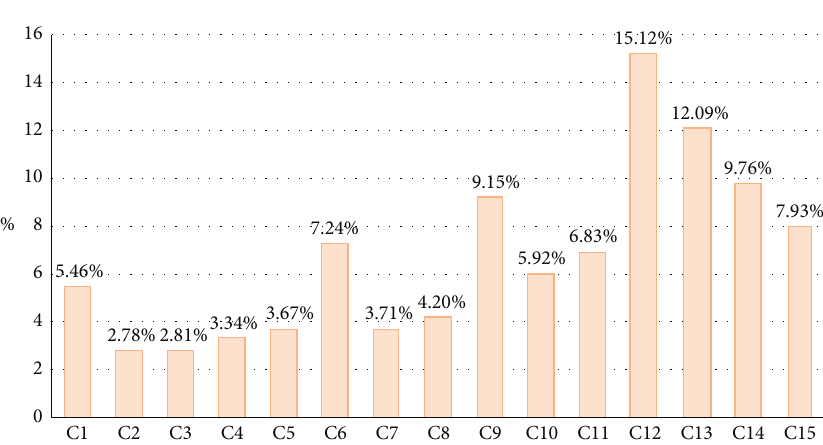
Figure 5: Weight of comprehensive ability evaluation index of accounting applied